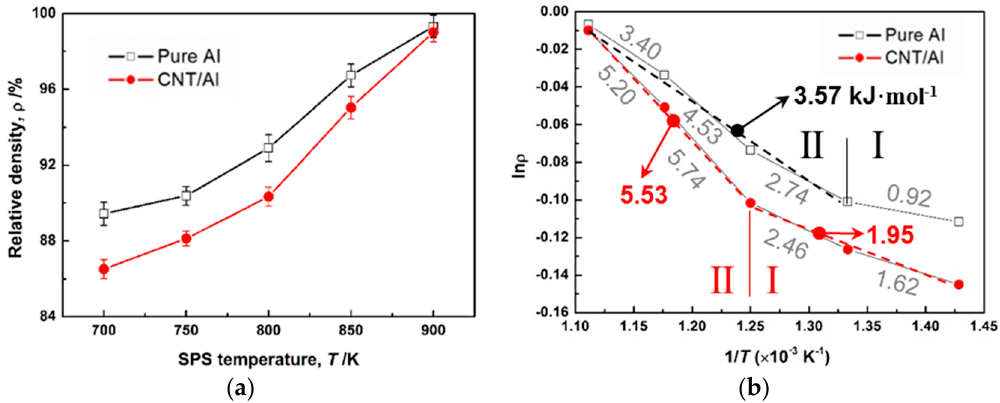
Figure 4. Sintering kinetics of pure Al and CNT–Al composites: ( a ) Relation between relative density ( ρ ) and SPS temperature ( T ). ( b ) Relation between ln ρ and 1/ T . The activation energy of sintering estimated from the slop is shown in ( b ).